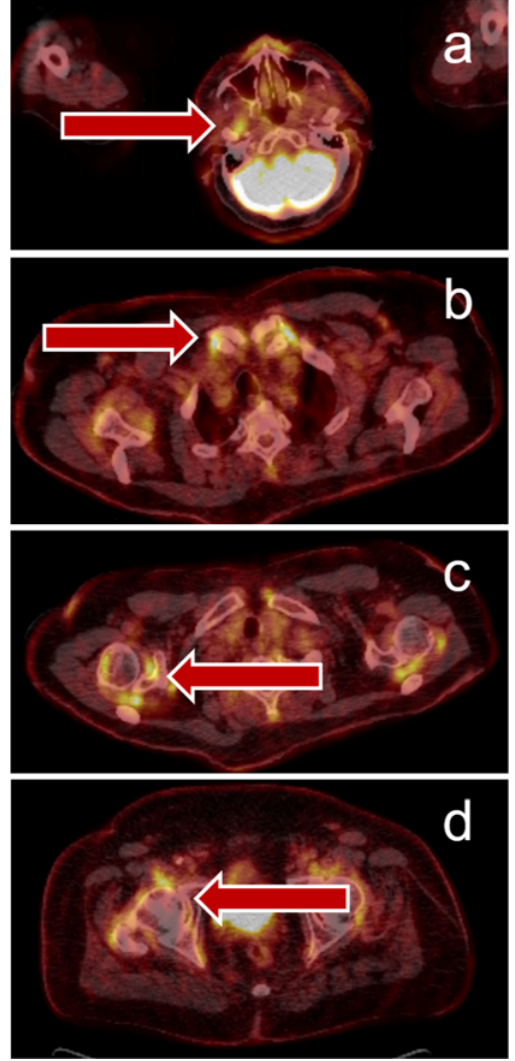
Figure 3. Immune ‐ related arthritis visualized by PET/CT: 69 ‐ year ‐ old man with stage IV NSCLC (PD ‐ L1 100%), small left hilar tumor, adrenal metastasis, and symptomatic brain metastasis – resected). The patient reported a history of chronic polyarthritis but did not require therapy at time of cancer diagnosis. The patient received six cycles of pembrolizumab monotherapy and reached partial remission. Due to increasing joint pain and suspected bone metastases, PET/CT was performed and showed a complete metabolic tumor remission, but hypermetabolic joint lesions (( a )– temporomandibular joints, ( b )—sternoclavicular joints, ( c )—shoulders, ( d )—hips) compatible with immune ‐ mediated arthritis. The patient received corticosteroid therapy and immunotherapy was paused, the joint pain improved.